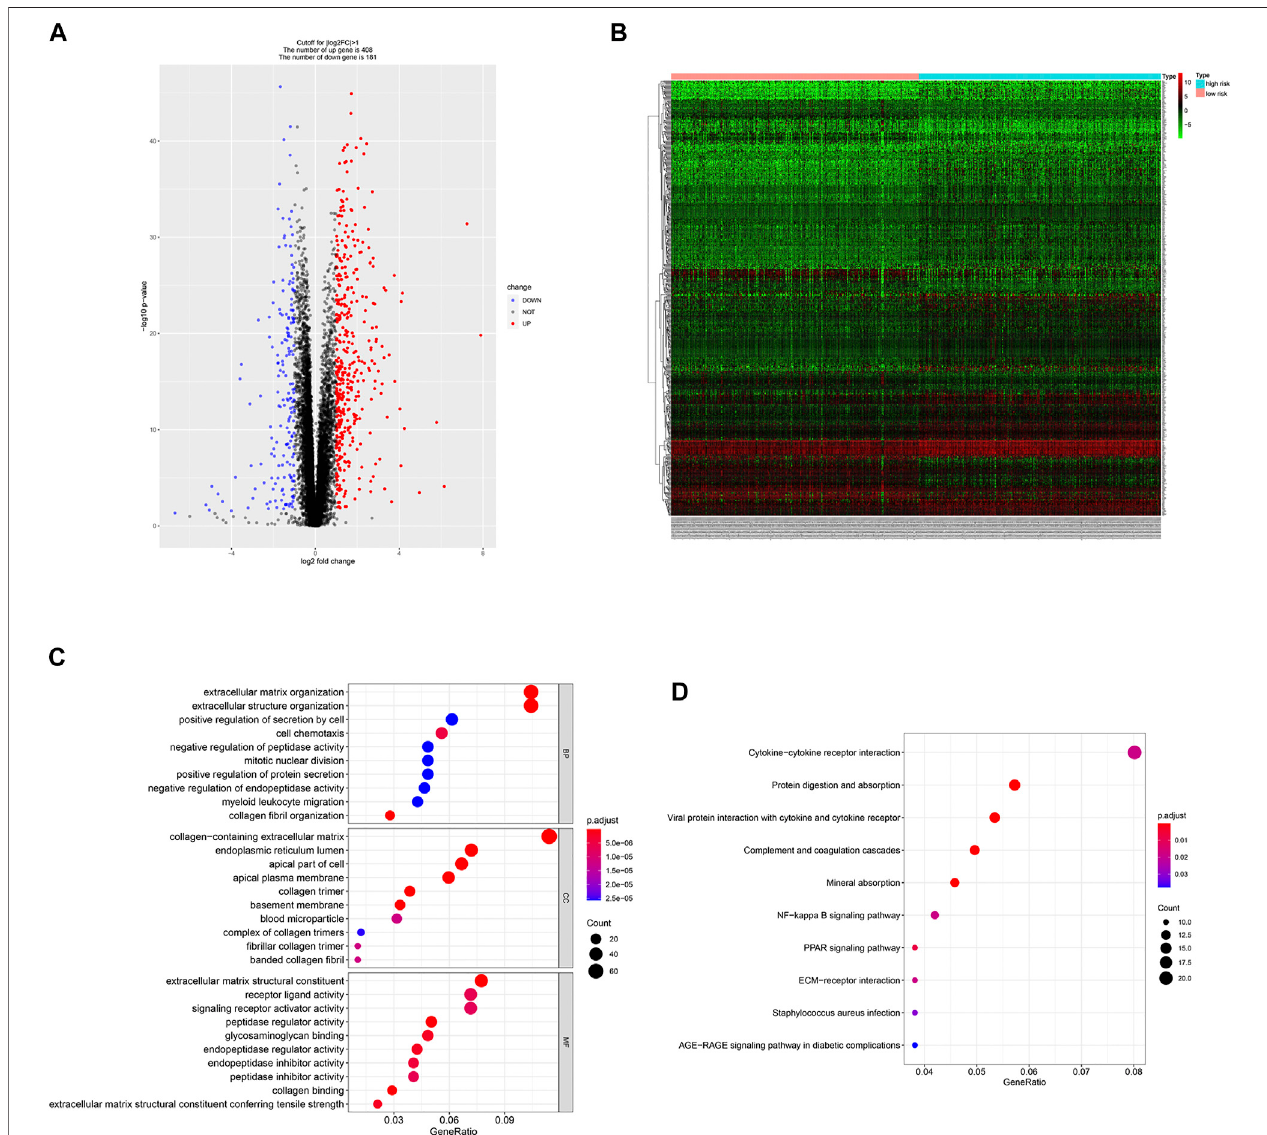
FIGURE 5 | DEGs identi fi cation and functional enrichment analysis. (A,B) Volcano plot and heatmap of 588 DEGs between low- and high-risk group. (C,D) Function enrichment analysis of DEGs.